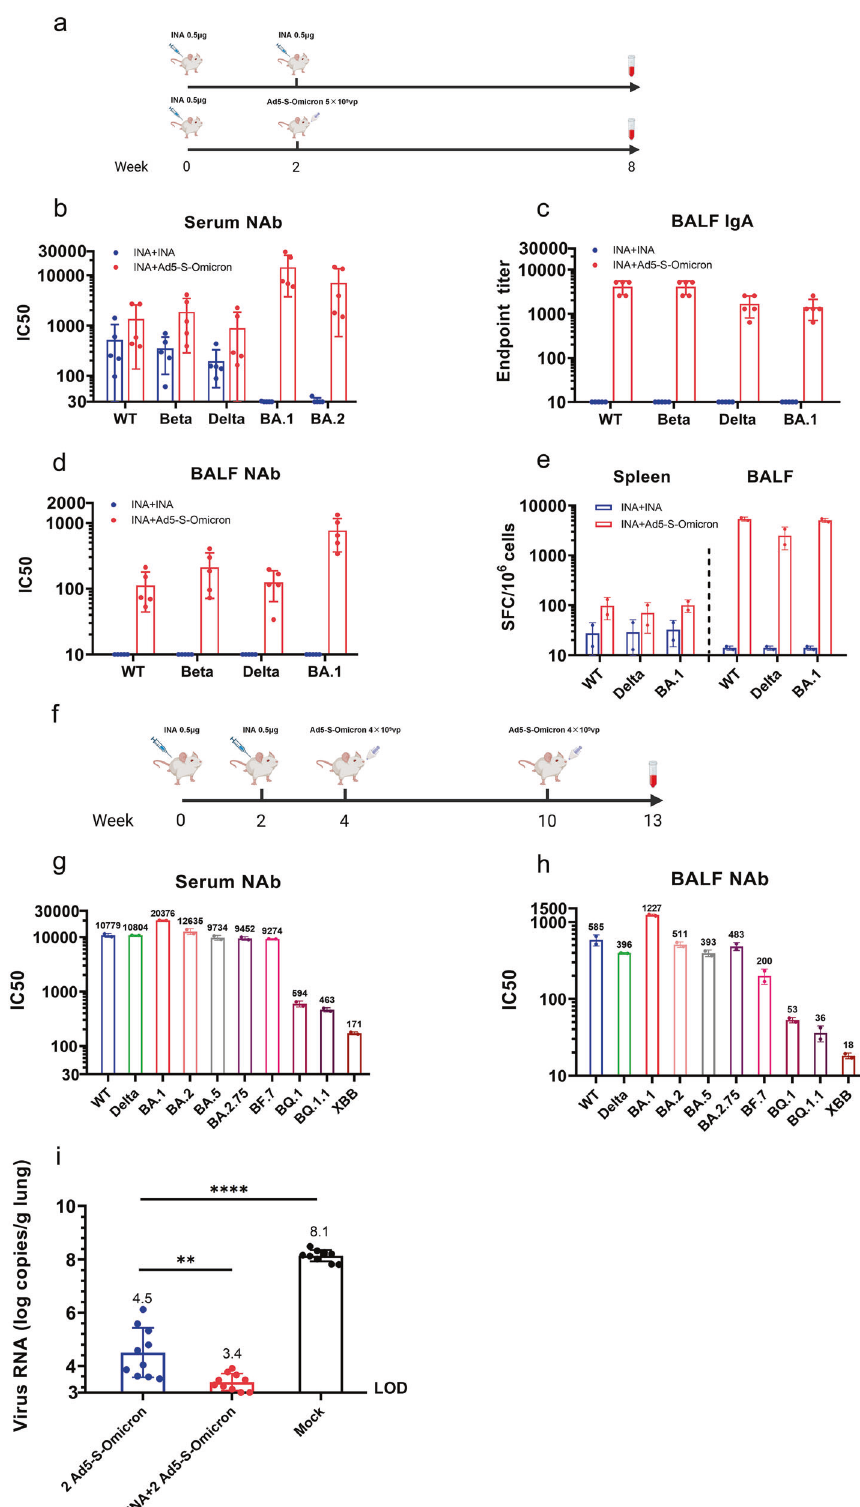
of inactivated vaccine (Fig. 2d). We also performed an IFN- γ ELISpot assay using spike peptide pools to evaluate the spike- speci fi c T cell response. Intranasal Ad5-S-Omicron elicited not only systemic but also respiratory tract T cell responses against Wildtype, Delta, and Omicron BA.1. The magnitude of spike-